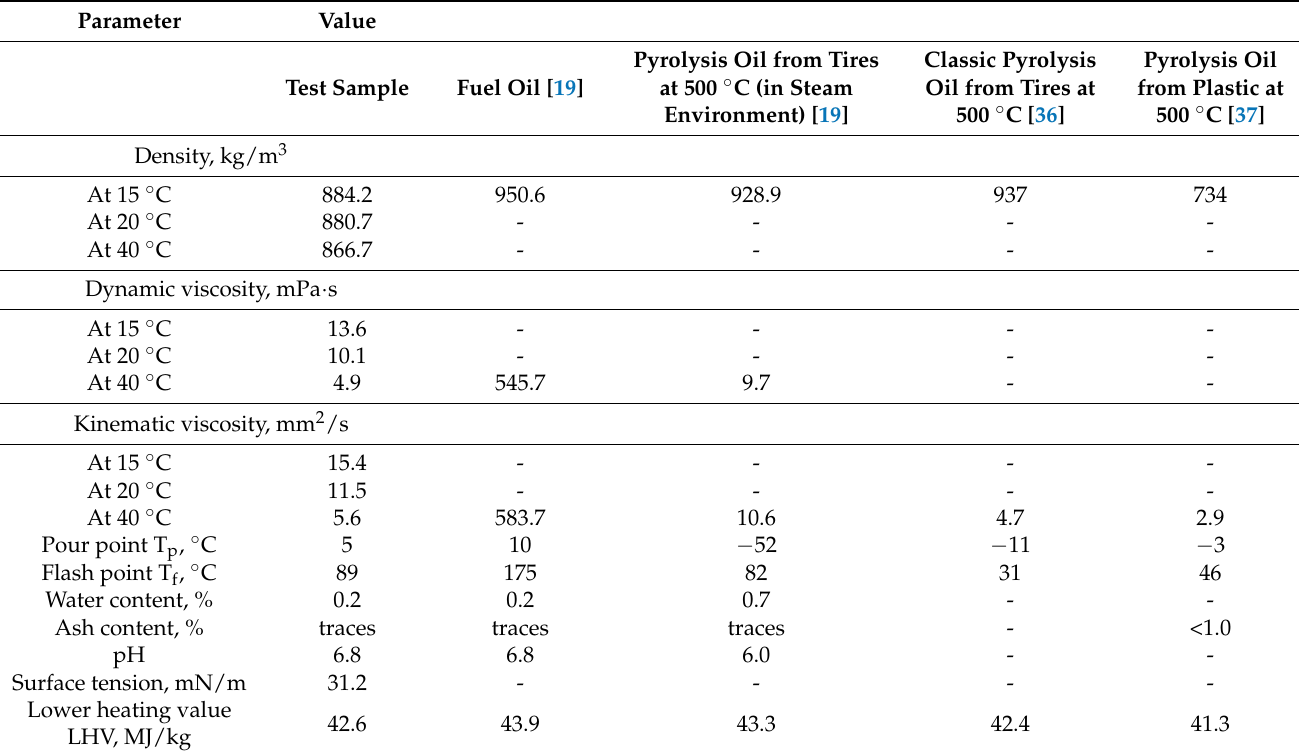
Table 3. Physicochemical characteristics of liquid hydrocarbons obtained after OS steam pyrolysis in comparison with other types of similar